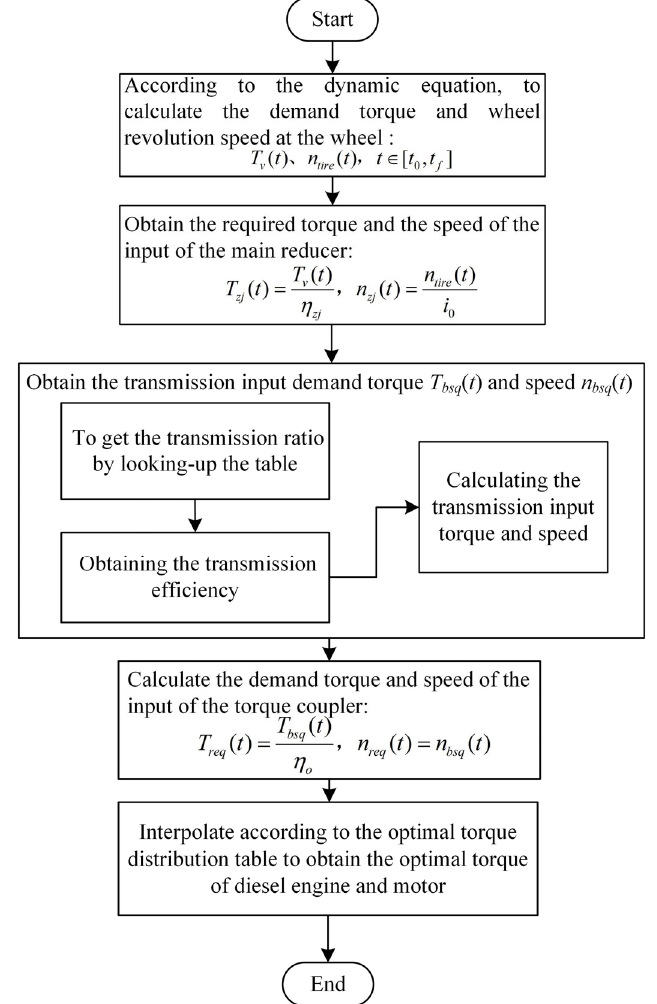
Figure 8. Torque distribution flowchart based on instantaneous optimization.